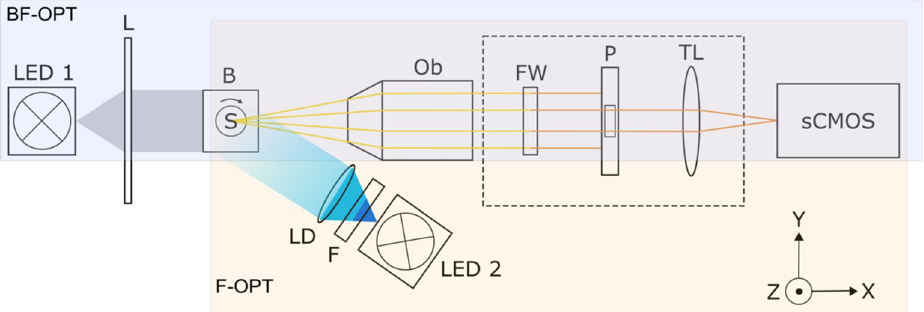
Figure 1. Schematic diagram of the OPT setup with both transmission (BF-OPT) and emission (F-OPT) modes represented: samples inserted in FEP tubes are rotated by the rotation stage (S) inside an index-matching water bath (B). A white light (LED 1) and a telecentric lens (L) are used for bright-field imaging in OPT. Fluorescence illumination provided by a LED (LED 2), a bandpass filter (F), and a collimated lens with a diffuser (LD) in fluorescence OPT mode. The detection system comprises an objective lens (Ob), a rotating filter wheel (FW) used as a band-pass filter (only for fluorescence imaging), a pinhole (P), a tube lens (TL), and a sCMOS camera.